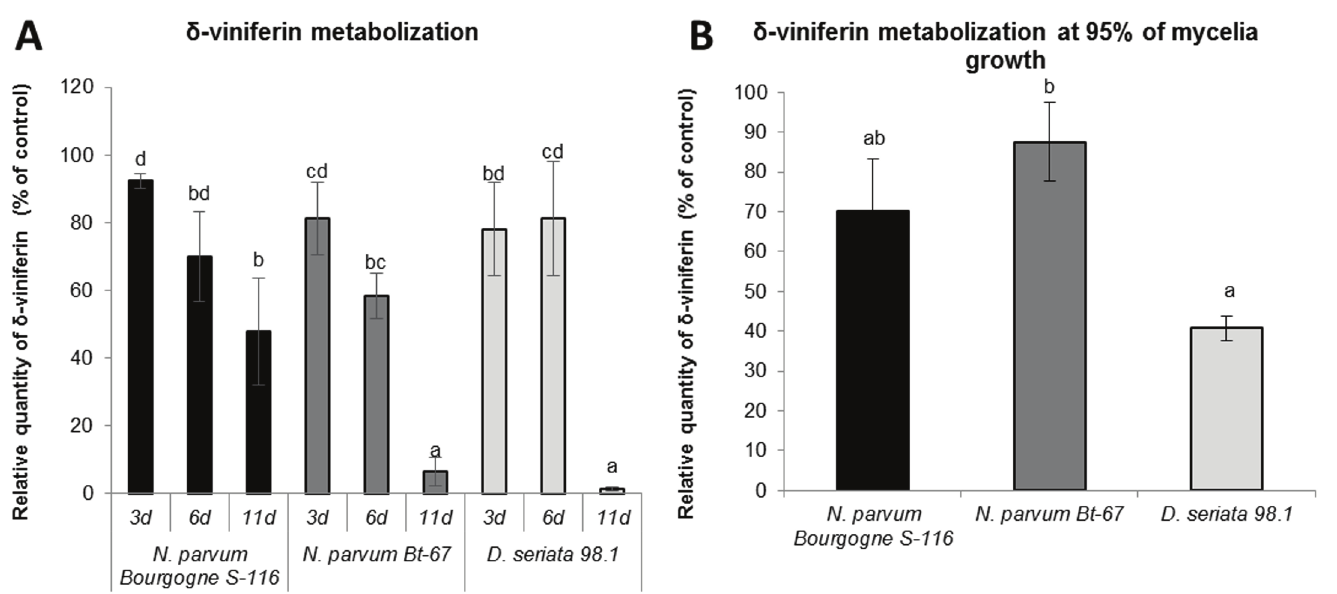
Fig 7. δ -viniferin metabolization by Botryosphaeriaceae fungi. δ -viniferin(initiallyadded at 50 μ M) was quantifiedby LC-MS in PDA medium extract of N . parvum BourgogneS-116, N . parvum Bt-67 and D . seriata 98.1. The δ -viniferinquantity is expressedin relative quantity (% of control) comparedto control medium without fungi at different time points (3, 6 and 11 days: A), or when fungi have saturated95% of the Petri Dish surface (B). Values are means and SD of three biologicalreplicates, each calculatedfrom the mean of three technicalreplicates. Means with a same latter are not significantly different at p (cid:20) 0,05 (Tukey